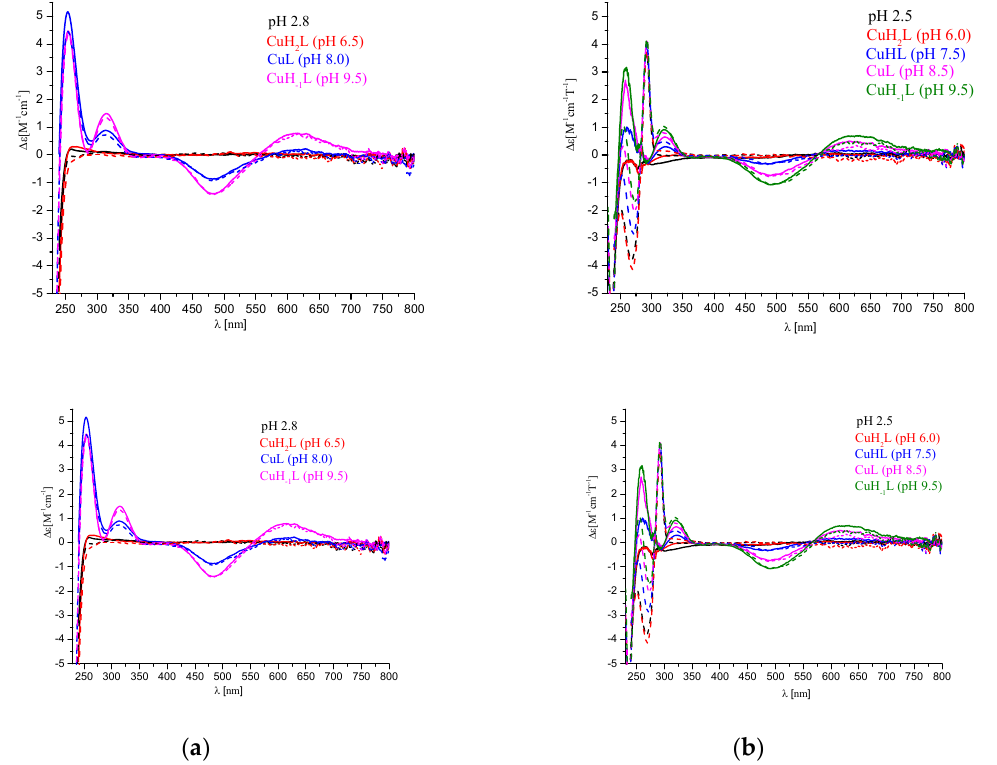
Figure 6. Comparison of CD (solid line) and magnetic circular dichroism (MCD) (dashed line) spectra for: ( a ) the Cu(II)/P1 system; ( b ) the Cu(II)/P2 system. The ligand concentrations were 7×10 −4 mol/L and pH-metric titrations were performed in a 0.3 mol/L KCl solution. Sample volumes were 2.0 mL. The pH values were established by adding small amounts of concentrated KOH and HCl solutions.